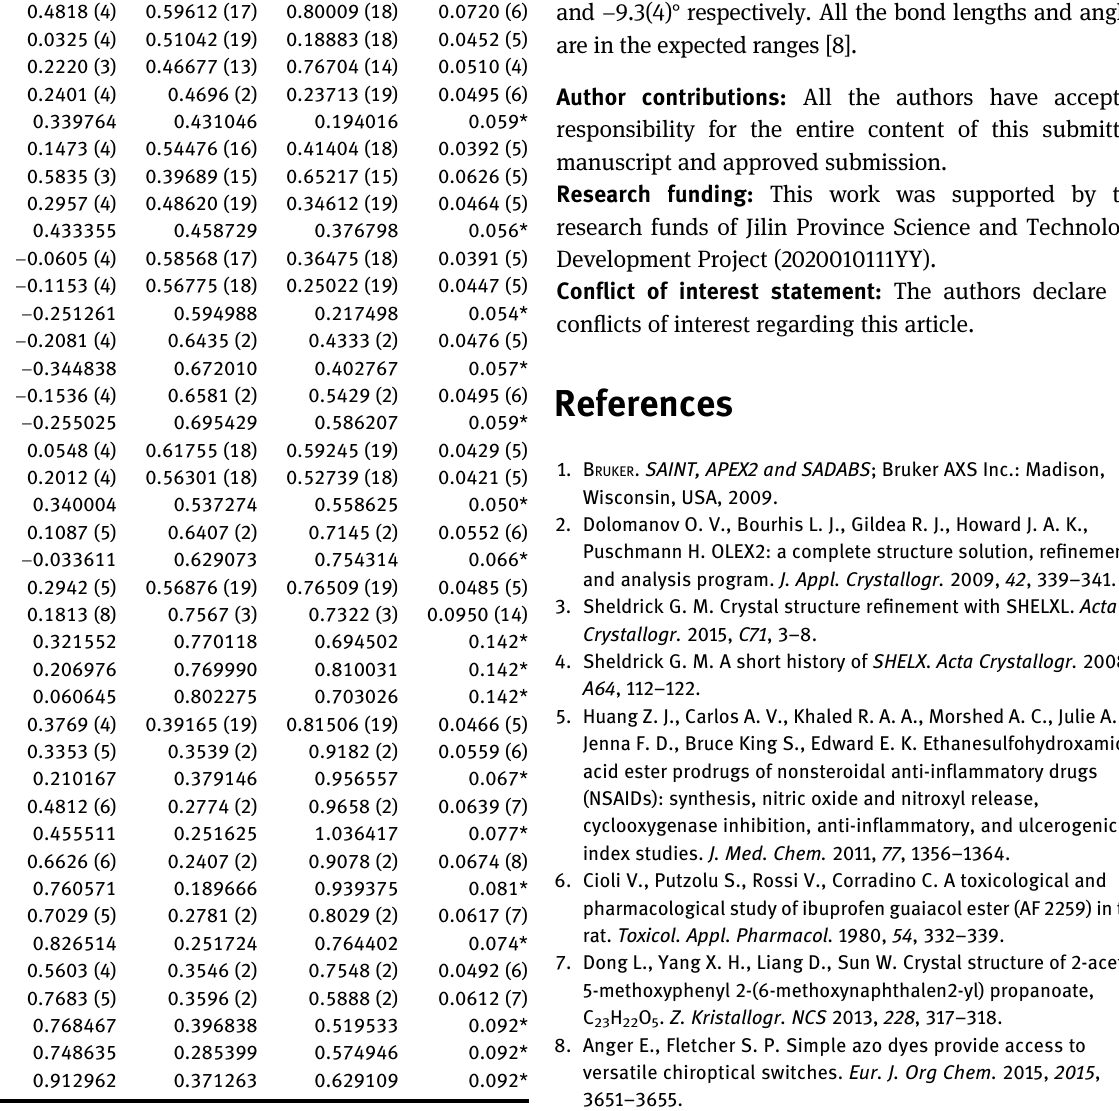
shown in the Figure. The molecule structure of the title compound is similar to the 2-acetyl-5-methoxyphenyl 2-(6-methoxynaphthalen2-yl) propanoate [7]. One carbon- oxygen double bond exists in the compound, the C – O double bond distance (C13 – O2) is 1.197(3) Å. The torsion